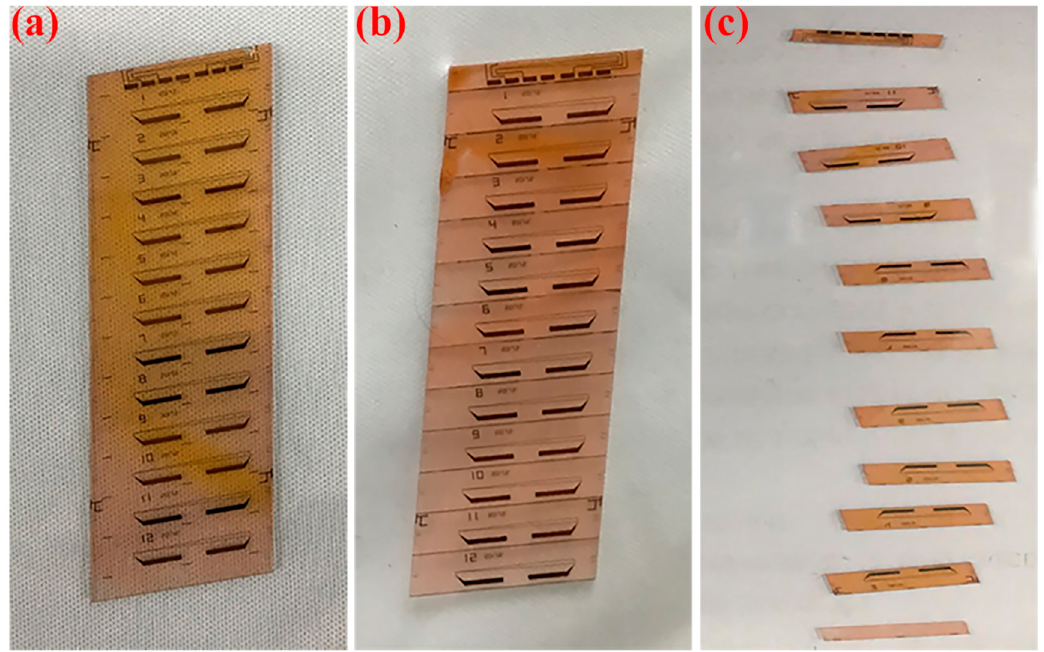
Figure 7. Images of LiNbO 3 wafer ( a ) before and ( b ) after laser dicing and ( c ) the separated electro-optic waveguide modulators.